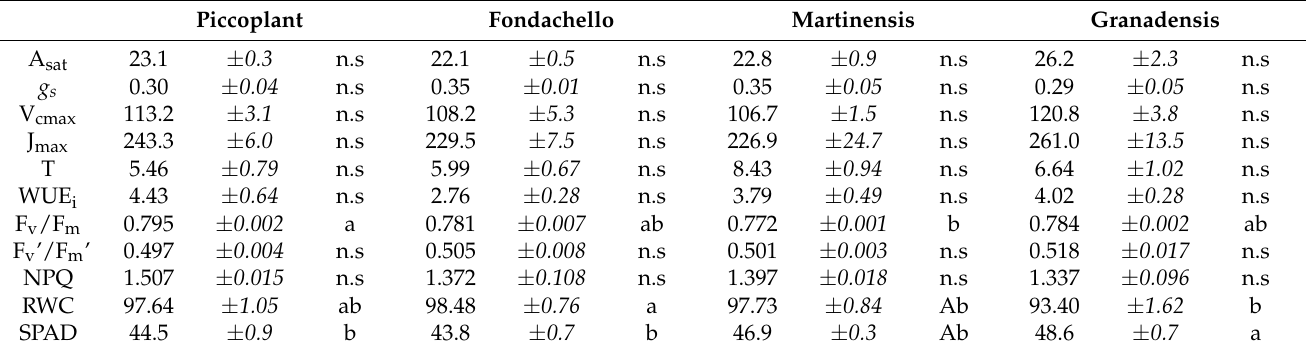
Table 2. Means and standard errors ( n = 3) of carbon assimilation (A sat ; µ mol CO 2 m − 2 s − 1 ), stomatal conductance ( g s ;